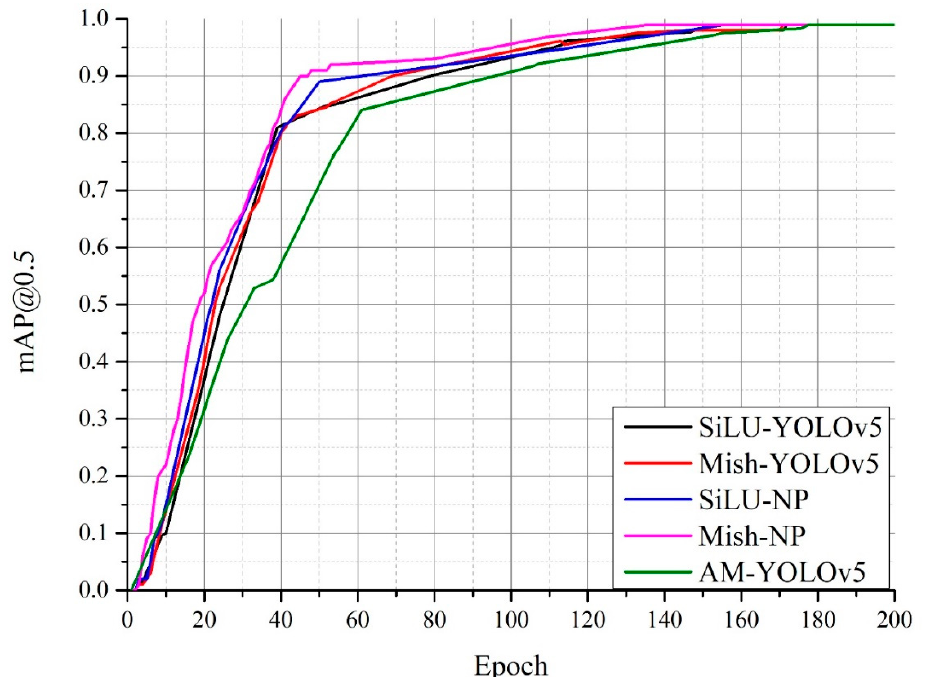
Figure 8. Comparison of the mAPs of the algorithms at IOU = 0.5.